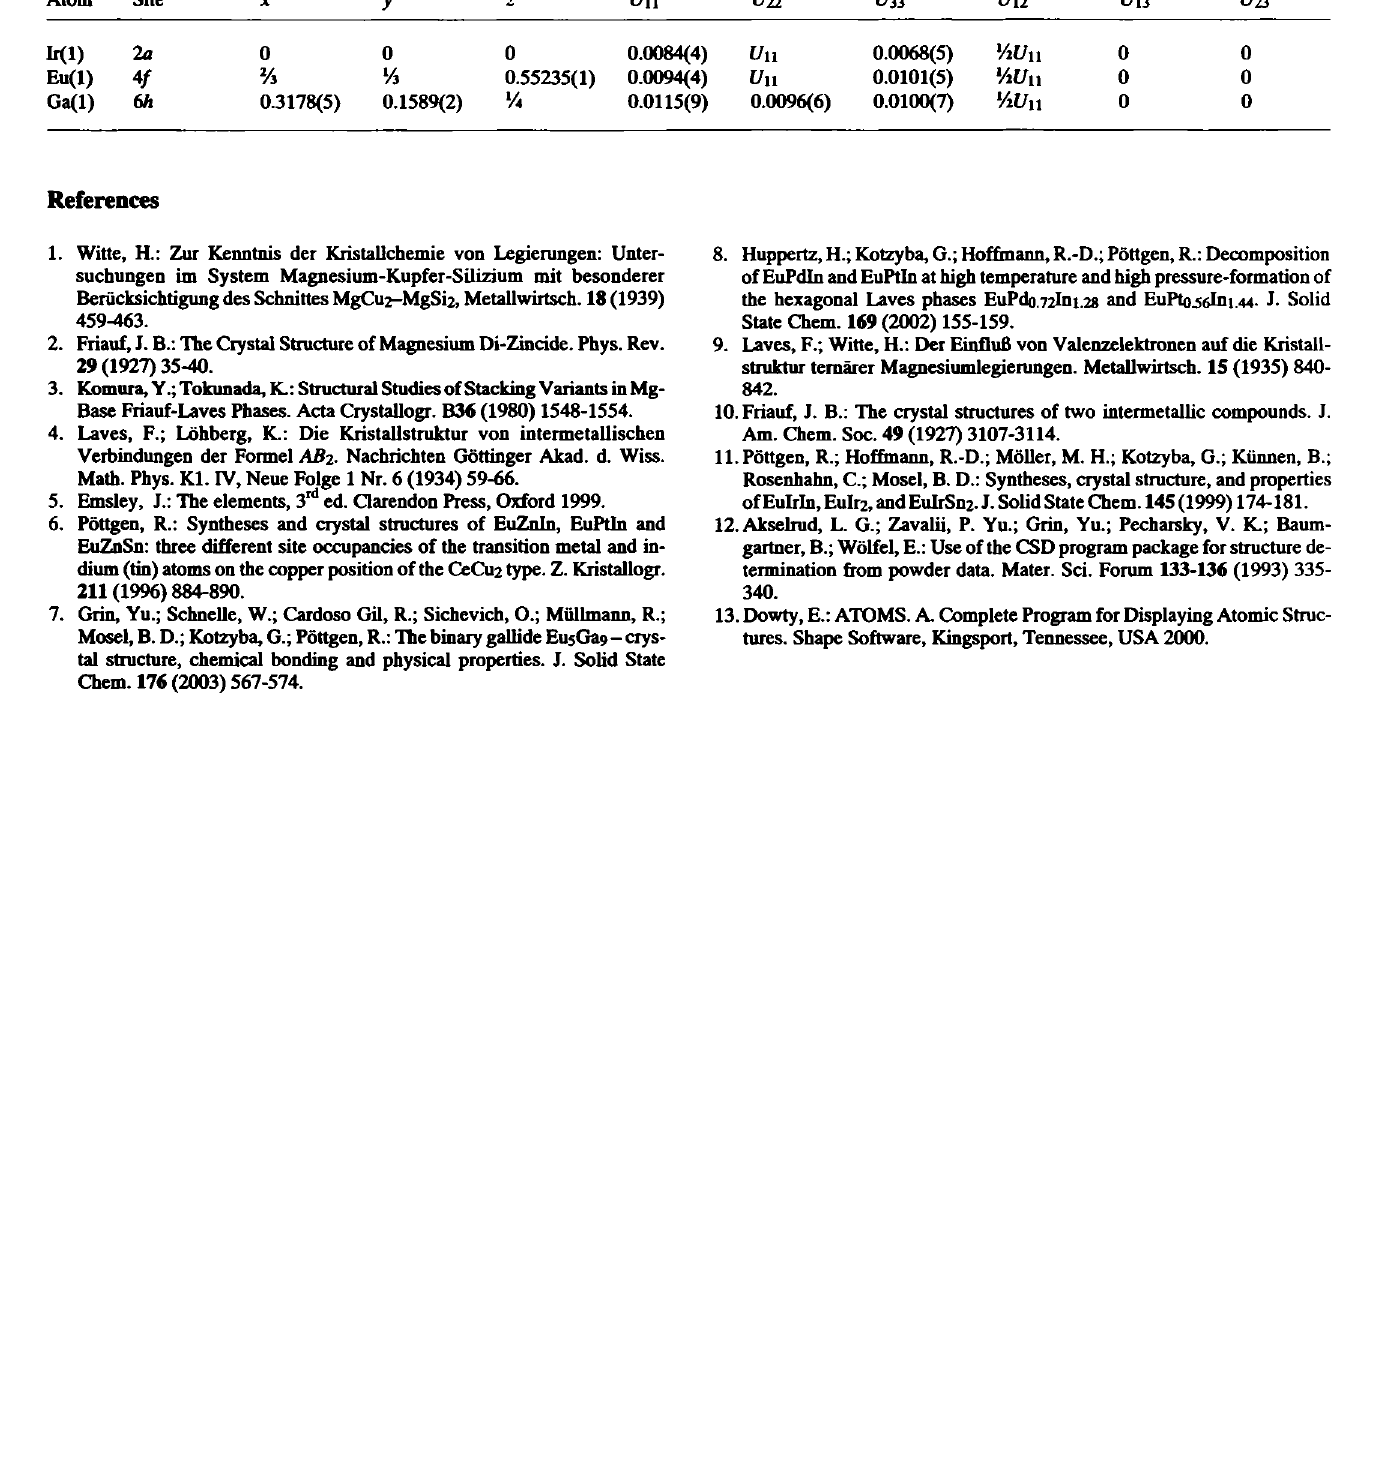
Table 2. Atomic coordinates and displacement parameters (in Ä 2